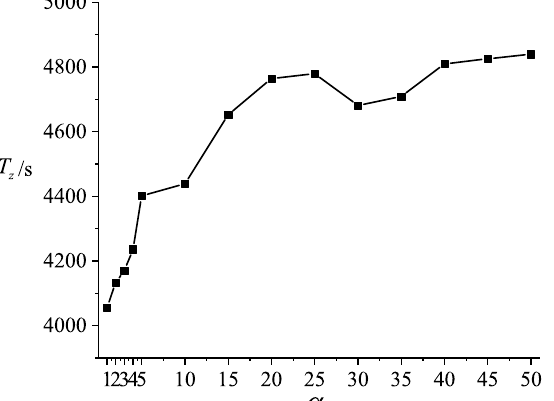
Figure 12. Variation curve of total time T z and pheromone weight α .